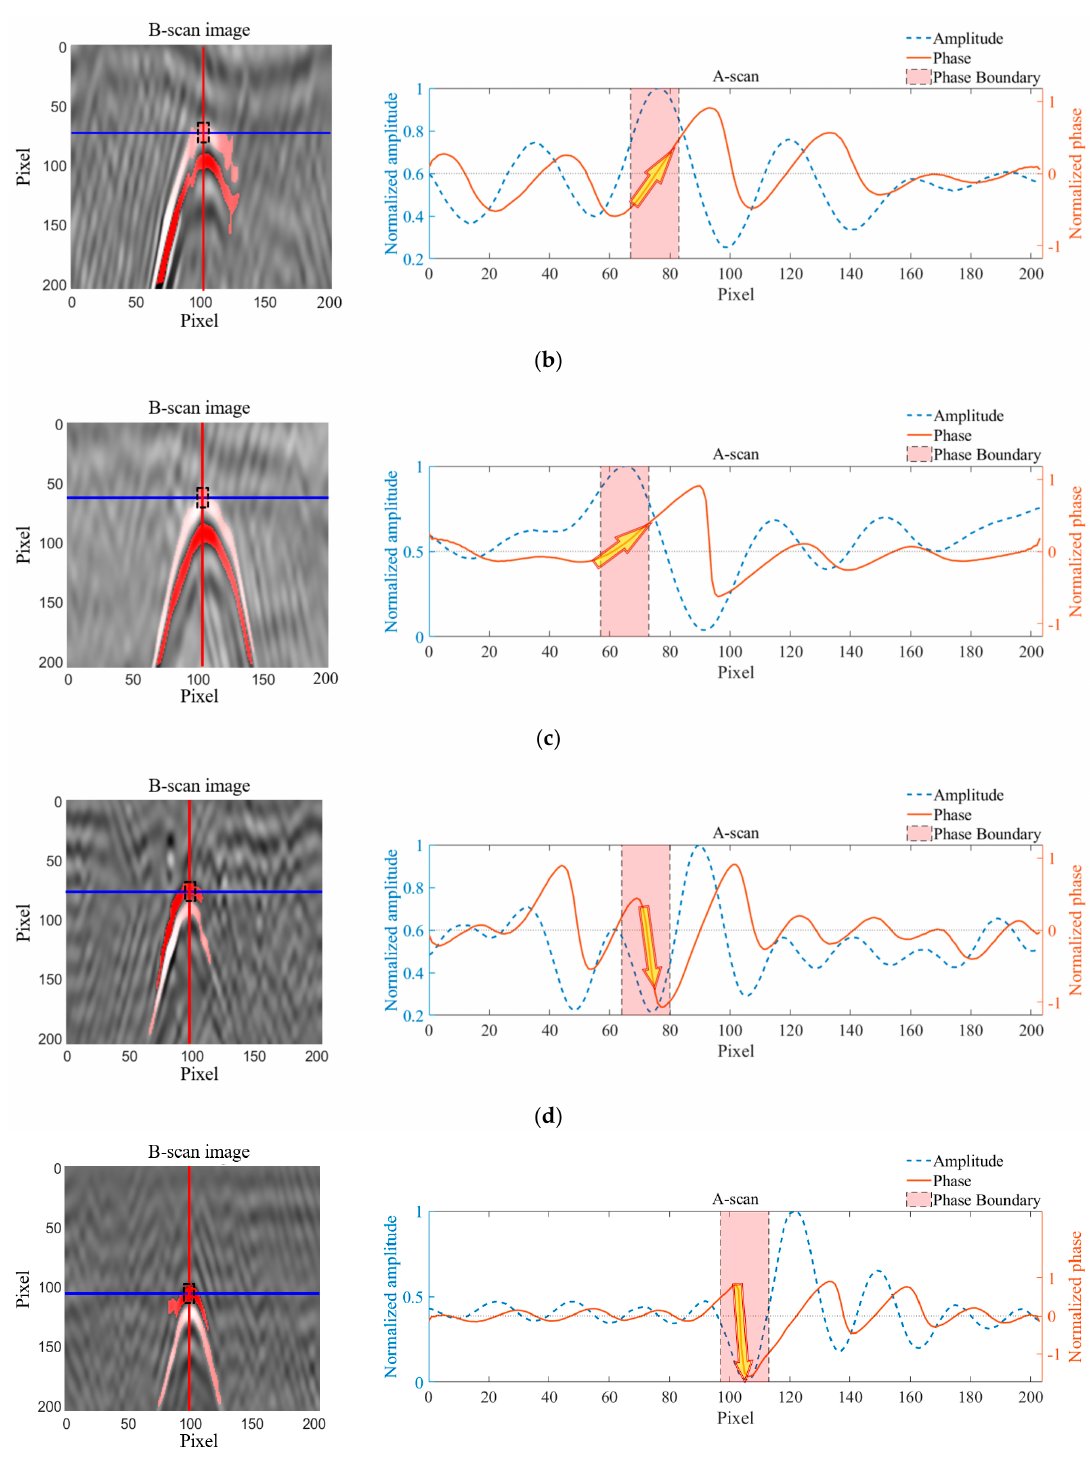
Figure 15. Phase analysis results at the extracted boundaries of ( a ) radiated wave, ( b , c ) cavities, and ( d , e ) gravels, respectively.